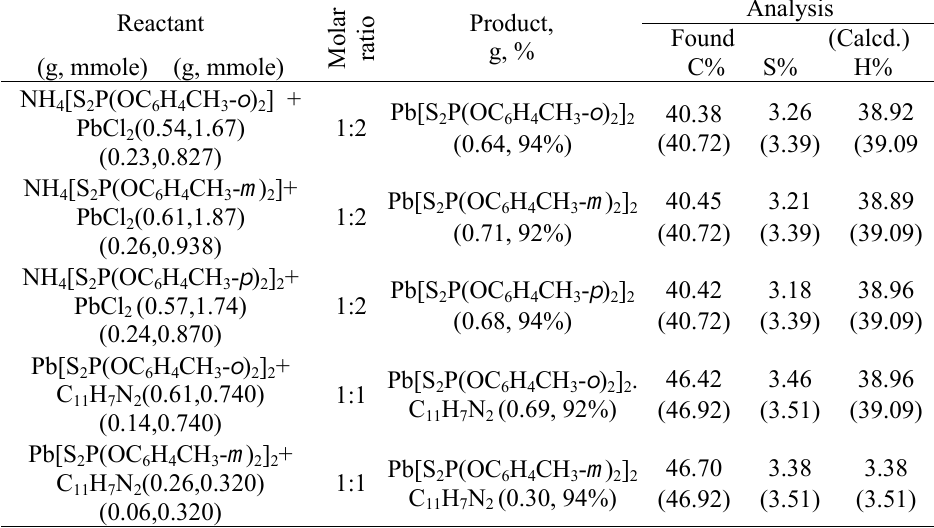
Table 3. Synthesis and analytical data of ditolyldithiophosphatolead(II)complexes Reactant